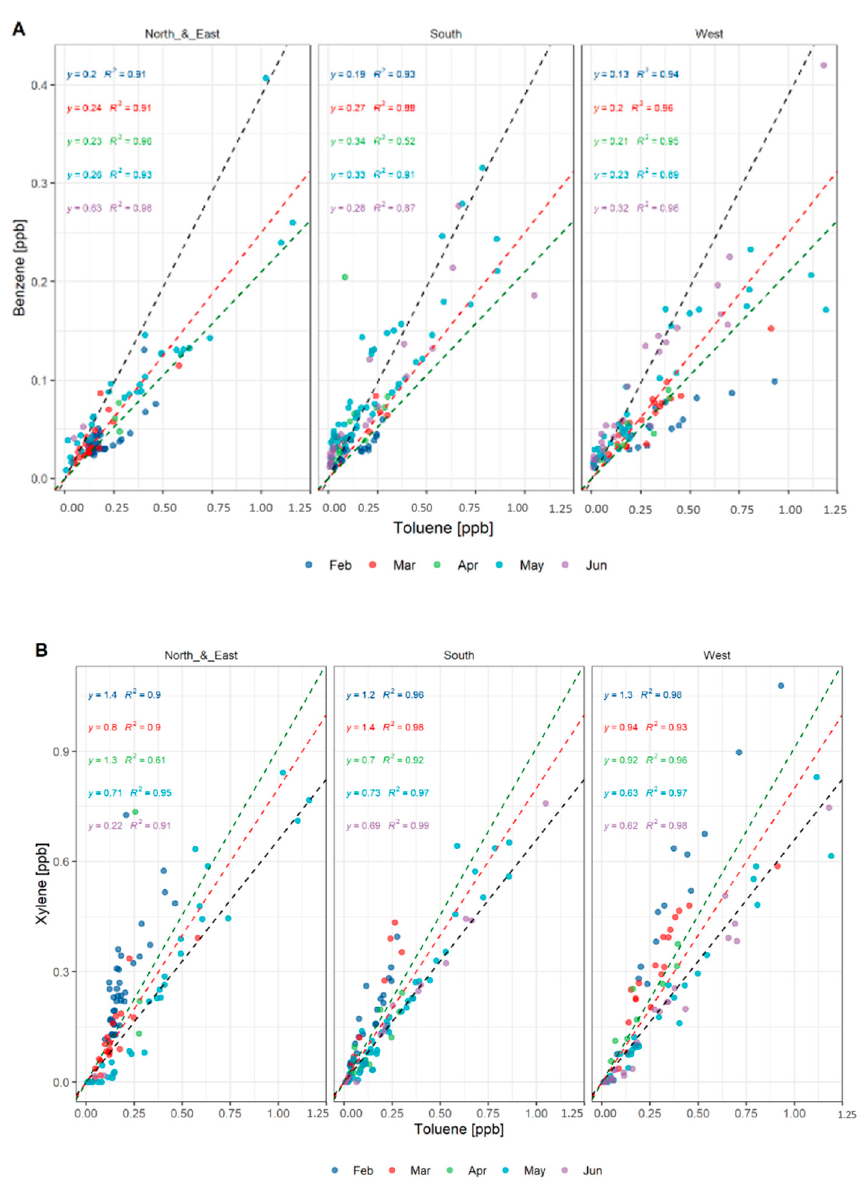
Figure 13. ( A ) Correlation plots of benzene to toluene, comparing our observations during the whole sampling period of COALA-JOEYS to the NSW emission inventory ratios. The black dotted line represents the NSW emission inventory ratio for the highest emitters (0.39). The red dotted lined represents the ratio for all the emissions in the area (0.25). The green dotted line represents the domestic + commercial emissions ratio (0.21). The value in the linear model represents the benzene/toluene ratio estimated for each month using a linear model. The colour of the points represents the month. Models for April might not be representative given the low number of samples taken during this month. ( B ) Correlation plots of xylene to toluene, comparing our observations during the whole sampling period of COALA-JOEYS to the NSW emission inventory ratios. The black dotted line represents the NSW emission inventory ratio for the highest emitters (0.66). The red dotted lined represents the ratio for all the emissions in the area (0.8). The green dotted line represents the domestic + commercial emissions ratio (0.91).